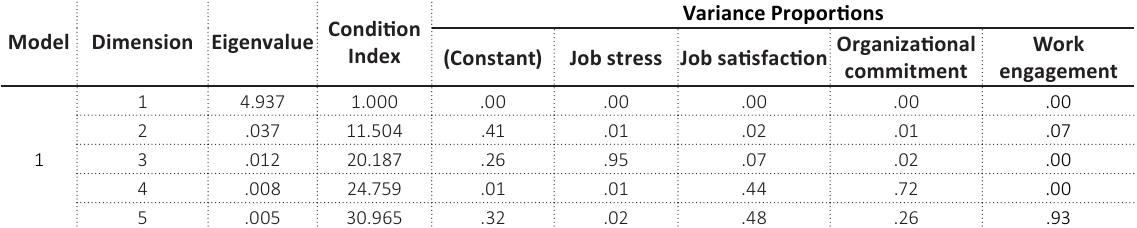
Model Dimension Eigenvalue Condition